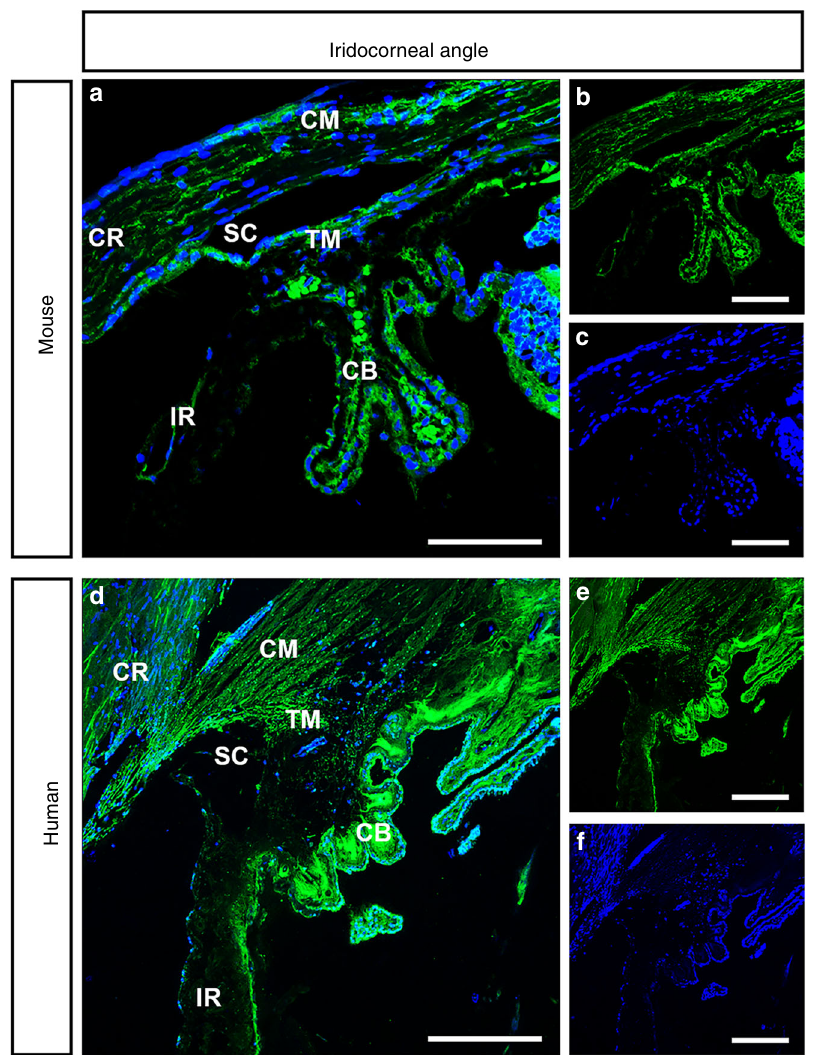
Fig. 4 Cellular localization of CACNA2D1 in C57BL/6 J mouse and human donor eyes. Cellular localization of CACNA2D1 in C57BL/6J mouse and human donor eyes. a – f Sections from C57BL/6J mouse ( a – c ) and human donor ( d – f ) iridocorneal angle were labeled with anti-CACNA2D1 antibodies. CACNA2D1 (green) is localized in the ciliary body (CB), trabecular meshwork (TM), Schlemm ’ s canal (SC), and ciliary muscle (CM) in both B6 mice and human donor eyes. CACNA2D1 was also present in the posterior pigmented epithelium of the iris. n = 2 mice and 1 human. Scale: 100 µ m. Blue nuclei, CB ciliary body, CM ciliary muscle, CR cornea, IR iris, SC Schlemm ’ s canal, TM trabecular The Cacna2d1 haplotype also in fl uenced the drug response. Figure 5b illustrates the percent reduction in IOP after Fig. 5a. Table 1 lists the pharmacodynamic parameters after application of 0.9% pregabalin eye drops into the eyes of DBA/ application of pregabalin eye drops and statistical evaluation of 2J, BXD48 ( D allele), C57BL/6J, and BXD14 ( B allele) mice. the data, respectively. Drops containing 0.3% drug provided no Table 2 lists the pharmacodynamic parameters after application IOP-lowering effect compared to control. All other concentra- of 0.9% pregabalin eye drops and statistical evaluation of the data, tions of drug reduced IOP in a dose-dependent manner. A pla- respectively. Mice with the B allele of Cacna2d1 (i.e., B6 and teau was reached at 0.9% and there was no signi fi cant difference BXD14) were more responsive to pregabalin (0.9%) eye drops in drug response between 0.9 and 1.2% drug ( P > 0.05). There than mice with the D allele (i.e., D2 and BXD48). In addition to was no signi fi cant difference between the time of maximum larger reductions in IOP, mice with the B allele of Cacna2d1 had response ( T max ) values of 0.6 – 1.2% concentrations of drug ( P > 0.05). In contrast, there was a signi fi cant difference between the larger T max , T end , and area under the curve (AUC total ) than mice with the D allele. Expanding this analysis to an additional time required for IOP to return to baseline ( T end ) for all con- centrations of pregabalin eye drops, ( P < 0.0001). The 1.2% species, we observed a similar IOP-lowering response (22.1 ± pregabalin eye drops extended the duration of the IOP-lowering 2.8%) in Dutch belted rabbits after instillation of 0.9% pregabalin effect of pregabalin above that obtained with 0.6% pregabalin. eye drops (Fig. 5c). Table 3 lists the pharmacodynamic Because there was no signi fi cant difference in the percent parameters and statistical evaluation of the data after reduction of IOP between 0.9 and 1.2% pregabalin, we selected application of 0.9% pregabalin eye drops into the eyes of Dutch 0.9% as the minimal concentration required to produce the belted rabbits. maximum reduction in IOP.